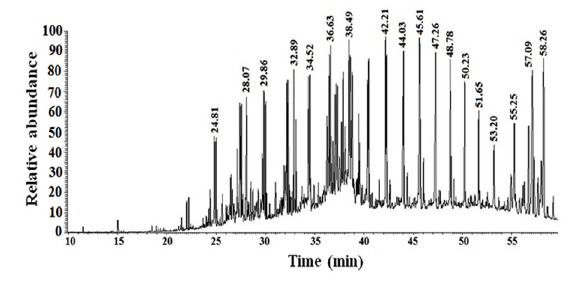
Fig. 9. GC/MS analysis of hexane soluble aliphatic fraction